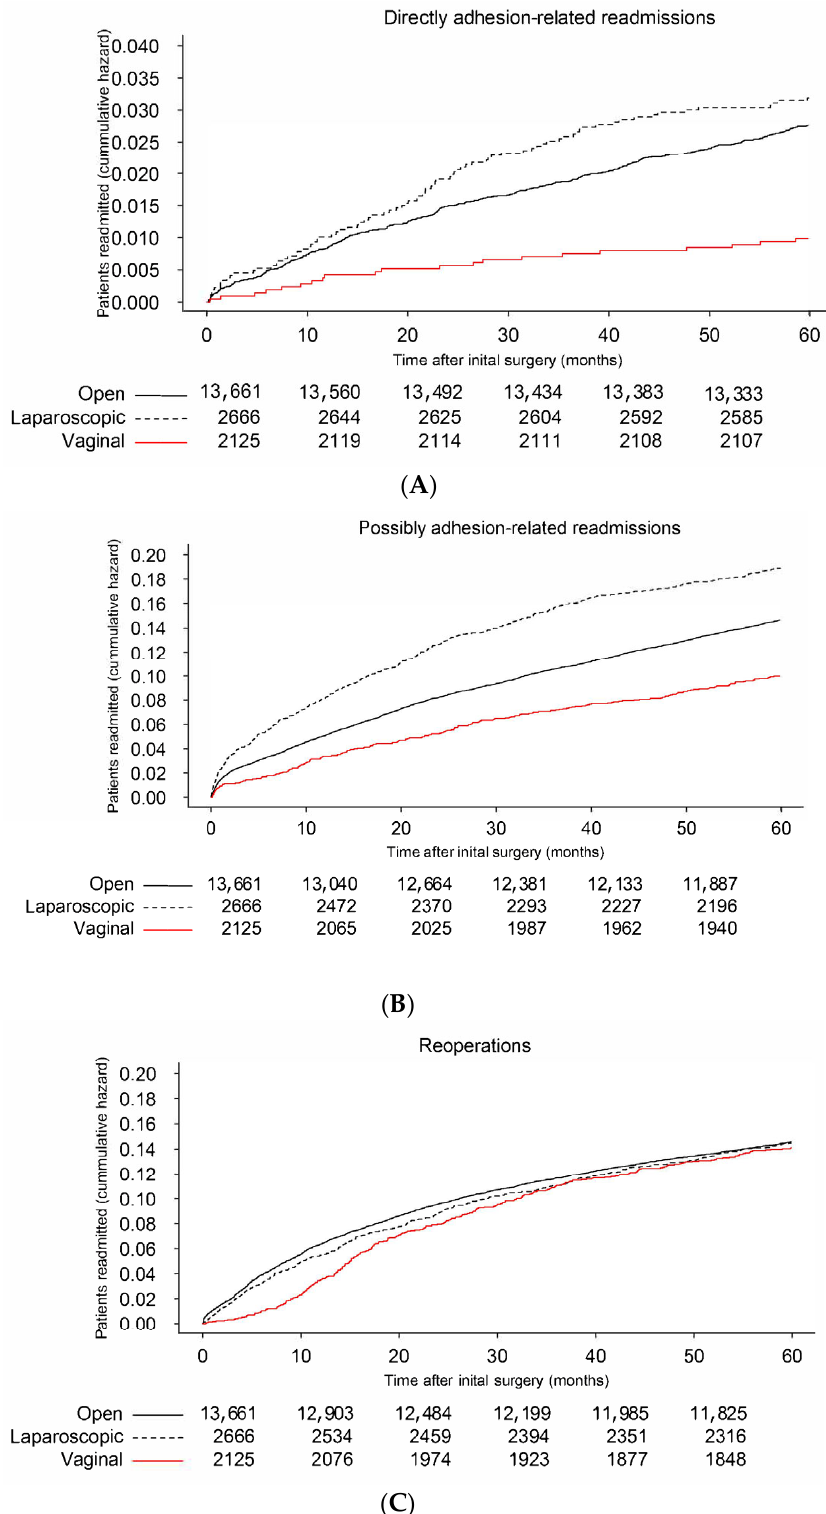
Figure 1. Kaplan–Meijer curve of directly adhesion-related readmissions ( A ), possibly adhesion- related readmissions ( B ), and reoperations after gynecological surgery ( C ). Table 2. Baseline characteristics.